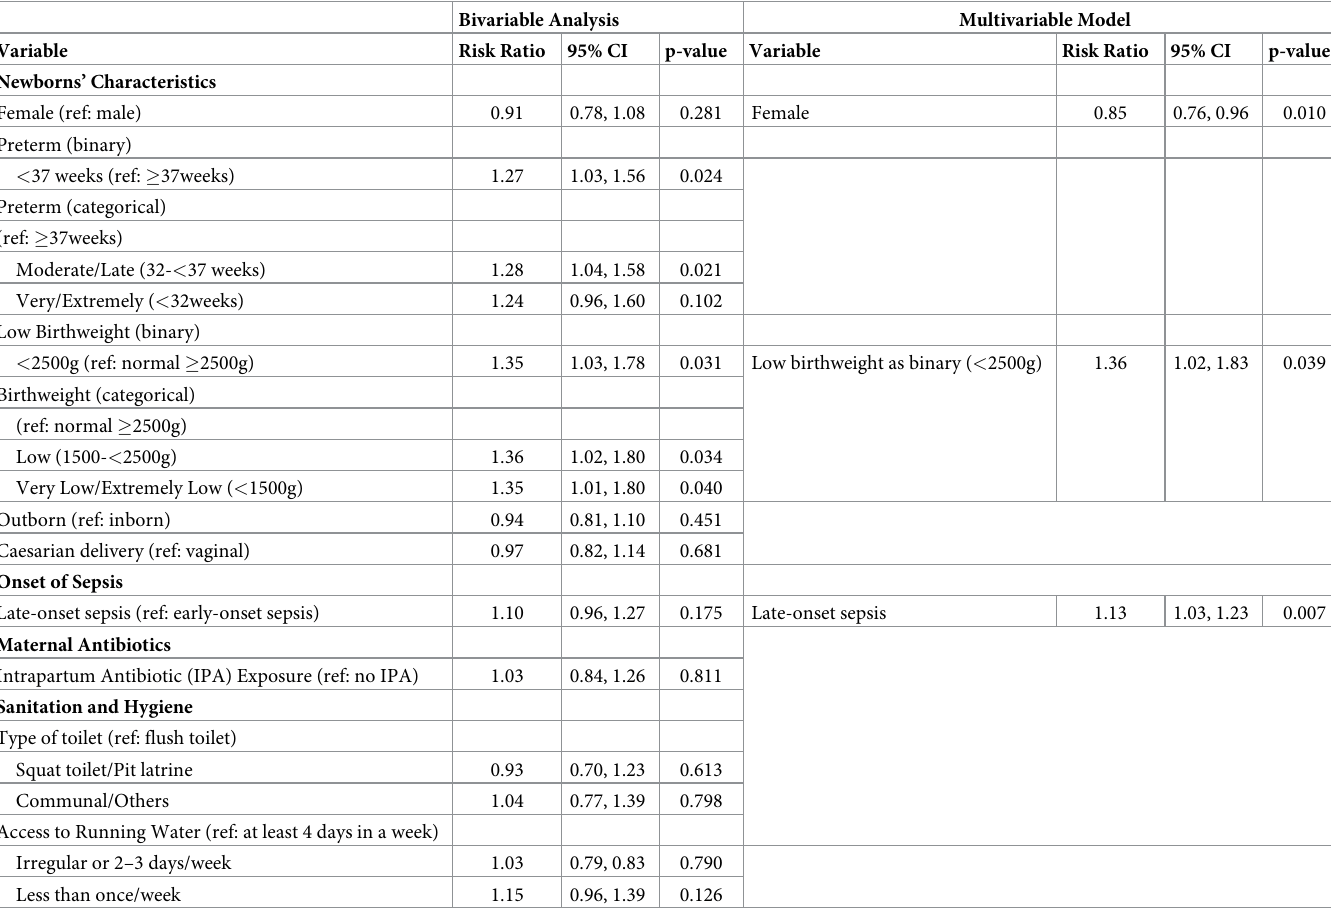
Table 2. Neonatal, maternal, and environmental factors associated with resistance to both ampicillin and gentamicin among 119 newborns with gram-negative